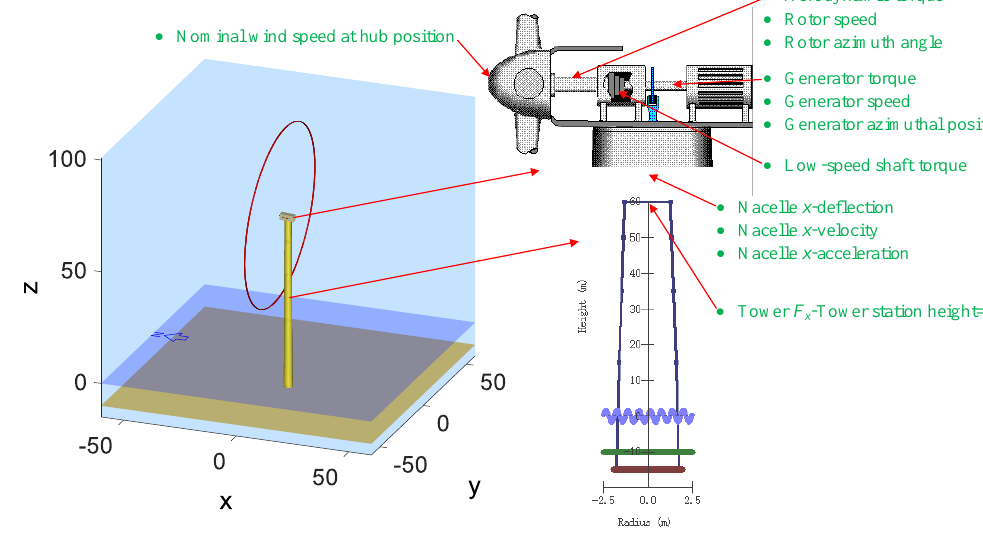
Figure 7. Diagram of wind turbine structure and sensor locations.